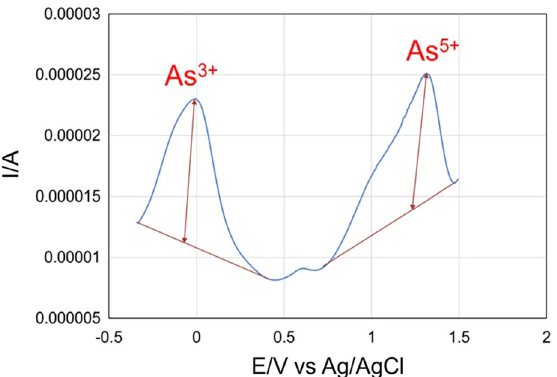
Figure 5. DPVs of 10 ppm arsenic concentration at GCE/P-Arg/ErGO-AuNPs sensor in pH 6.0 phosphate buffer at a scan rate of 50 mV s −1 . The condition of DPV measurements was initial potential − 1.0 V, end potential 2.0 V, pulse width 50 ms, modulation 50 mV, and pulse period 0.1